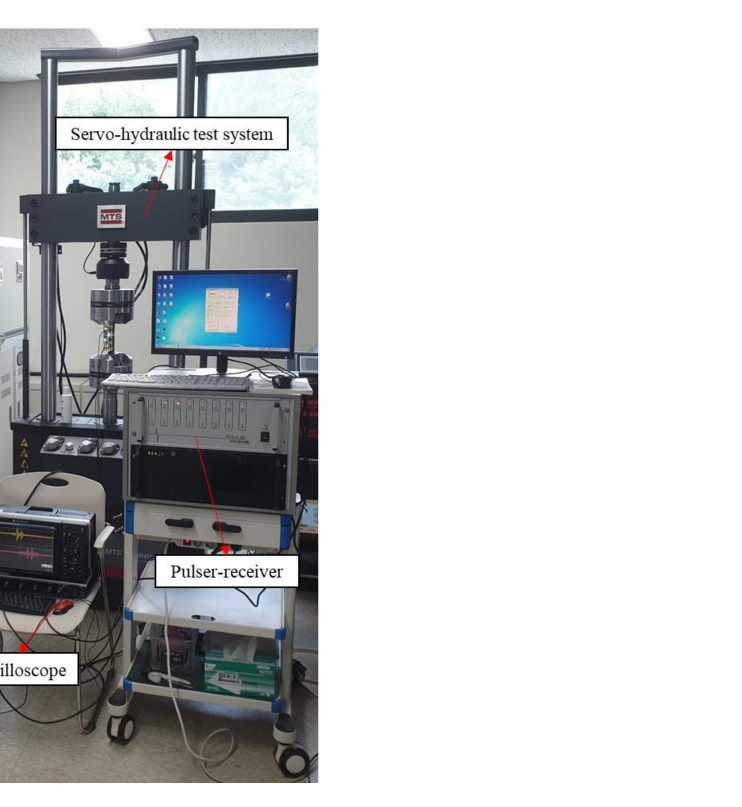
Figure 6. Photograph of the experimental setup for measuring tensile stress using L CR